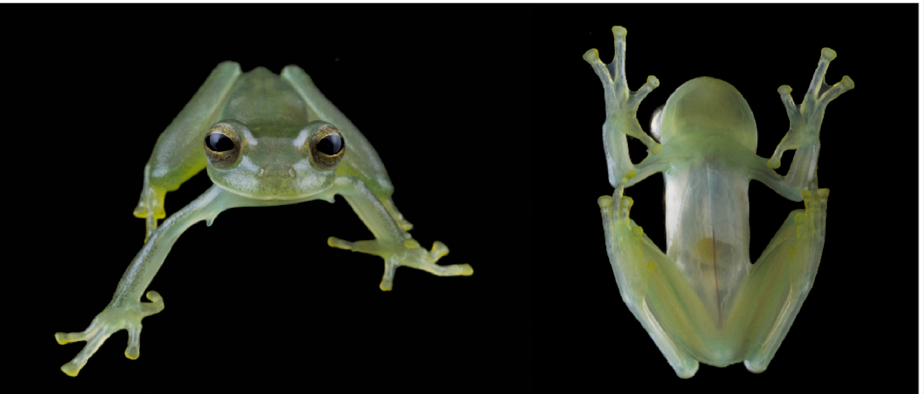
Figure 93. Espadarana durrellorum in life. Ecuador, Napo province, Comunidad Ñukanchi Allpa, 403 m, QCAZ 47909. Photos by Luis A. Coloma.